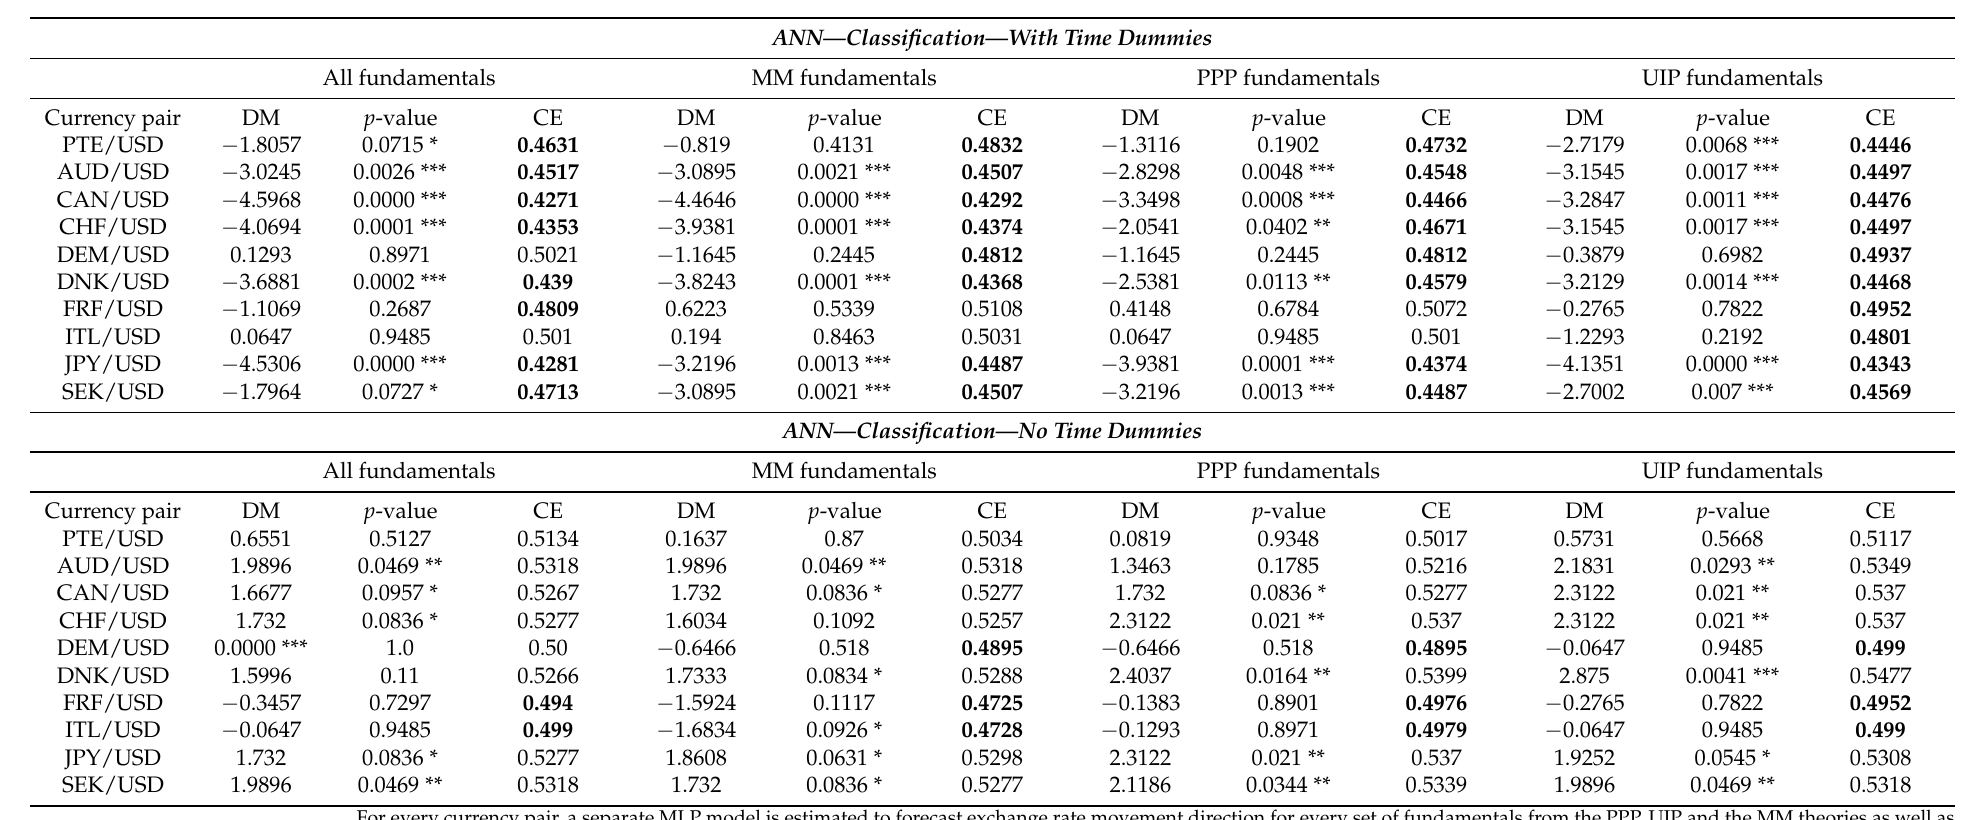
Table 4. One-month-ahead forecasting of exchange rate direction with fundamentals using